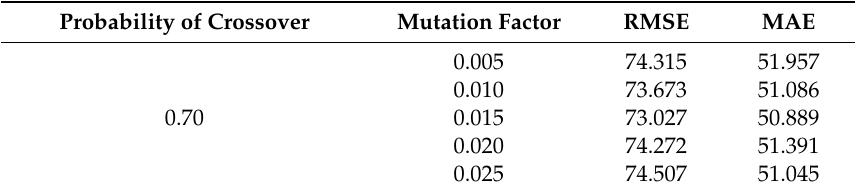
Table 5. The forecasting results with di ff erent mutation factors.